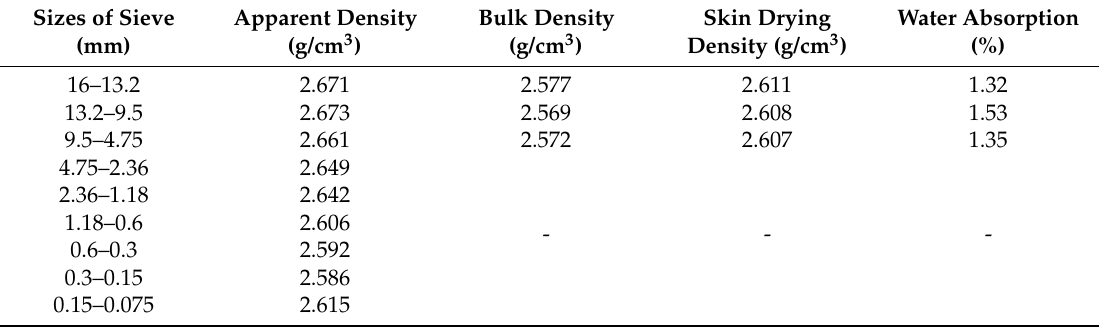
Table 2. Densities of limestone